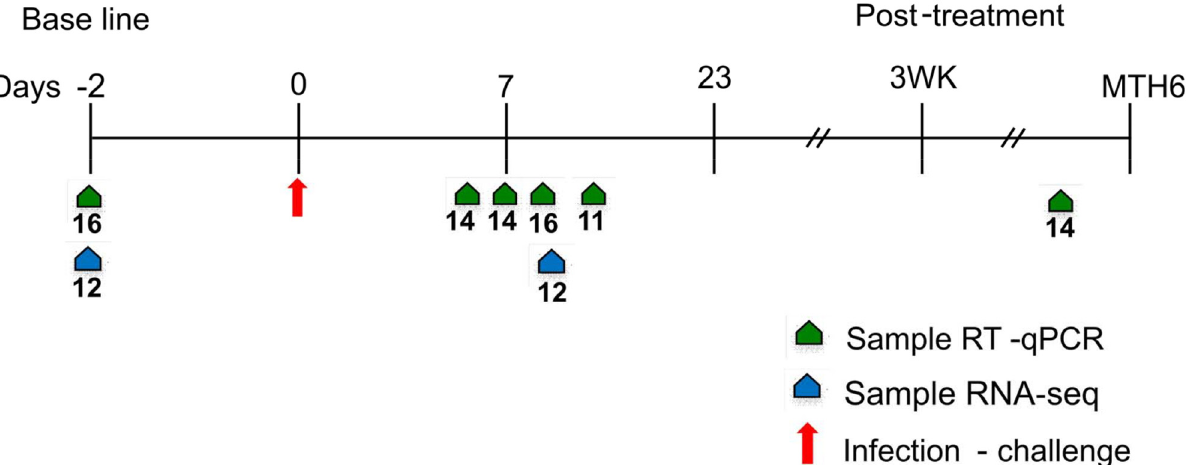
Fig 1. Experimental design. The time line sample collection, 85 total samples for RT-qPCR analysis and 24 total samples for RNASeq. Green arrows represent timepoints where RT-qPCR Pre-challenge, 16 samples (7 Cali, 9 Buenaventura); Day 5, 14 samples (6 Cali, 8 Buenaventura); Day 7, 14 samples (5 Cali, 9 Buenaventura); Day 9, 16 (7 Cali, 9 Buenaventura); Diagnosis by tick blood smear day (Day 12 – 13), 11 samples (5 Cali, 6 Buenaventura) and Month 4, 15 samples (6 Cali, 9 Buenaventura). Blue arrows shows samples used for the RNASeq analysis 12 per each timepoint Diagnosis day and Pre- challenge (6 Cali, 6 Buenaventura) 24